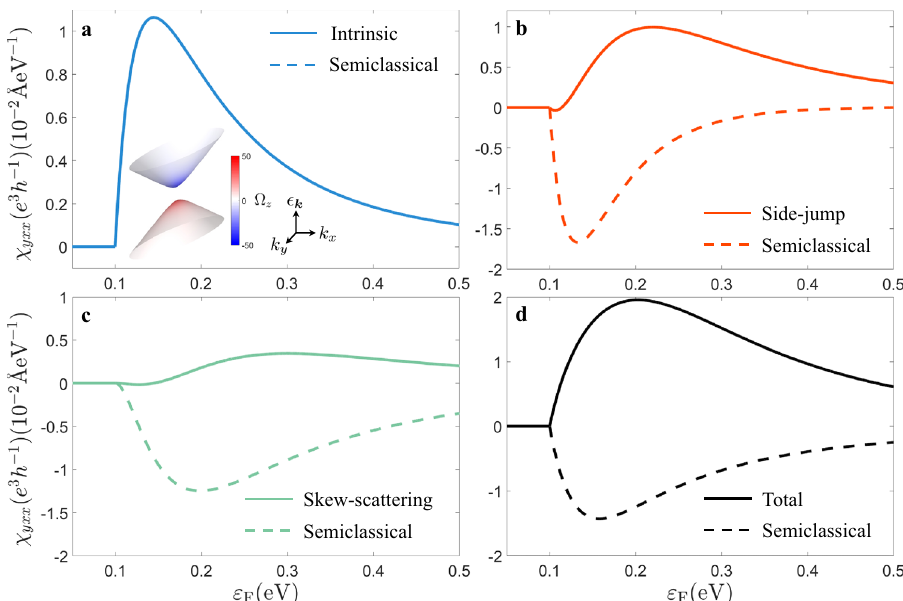
Fig. 3 Nonlinear Hall conductivity of a 2D tilted Dirac model. a – d The intrinsic, side-jump, skew-scattering, and total contributions to the nonlinear Hall conductivity χ yxx of the 2D tilted massive Dirac model [Eq. 7] as functions of the Fermi energy ε F at zero temperature. The semiclassical results (dashed lines) are also shown for comparison. The inset of a shows the two energy bands of the model. The color bar stands for the value of the Berry curvature. The model parameters are t = 0.1 eV ⋅ Å , v = 1 eV ⋅ Å , m = 0.1 eV, n i V 2 ¼ 10 2 eV 2 (cid:5) Å 2 and n i V 3 ¼ 10 4 eV 3 (cid:5) Å 4 0 1